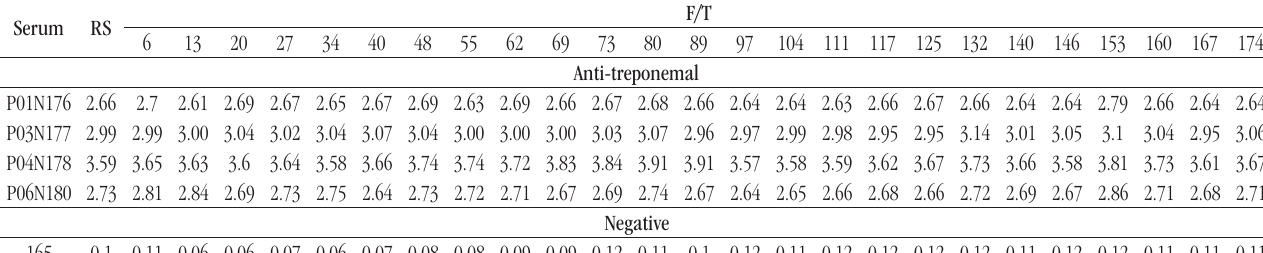
taBLE 1 − Results expressed by the index value, in the chemiluminescence assay – Advia Centaur-Syphilis –, calculated by mean of the values of three determinations in RS and F/T serum samples